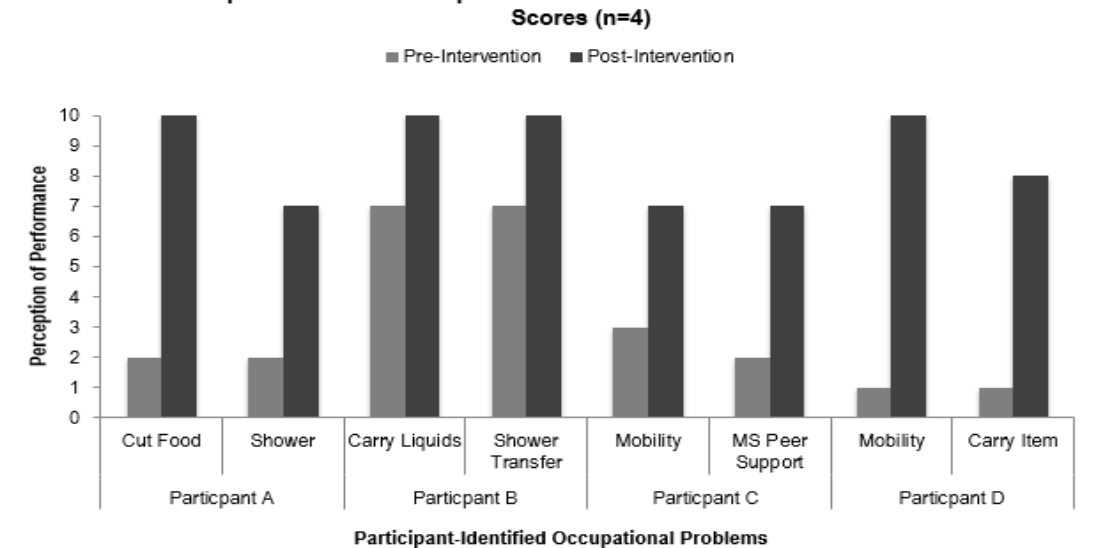
Figure 4. Comparison of pre and post-intervention perception of performance scores using the COPM (n=4). Two performance problems for each participant are included, along with pre- and post-intervention perception of performance scores